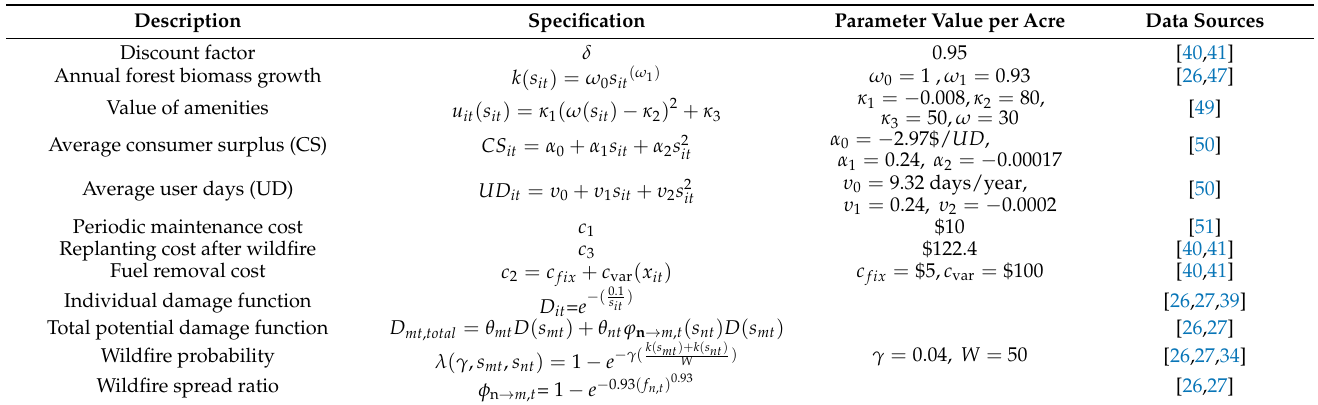
Table 1. Optimization model specification, functional forms, and data sources for a forest in the Southeastern